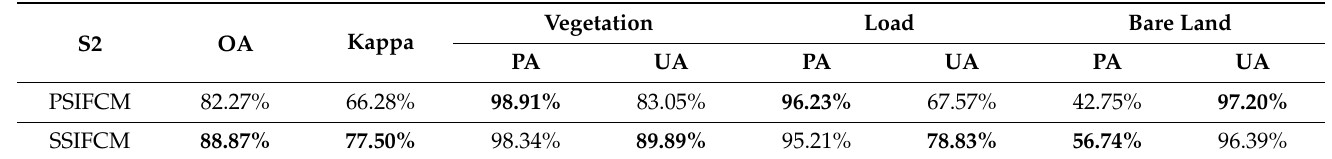
Table 2. Evaluation of S2 image pixel-level and object-level spatial intuitive fuzzy clustering algo- rithms classification results.